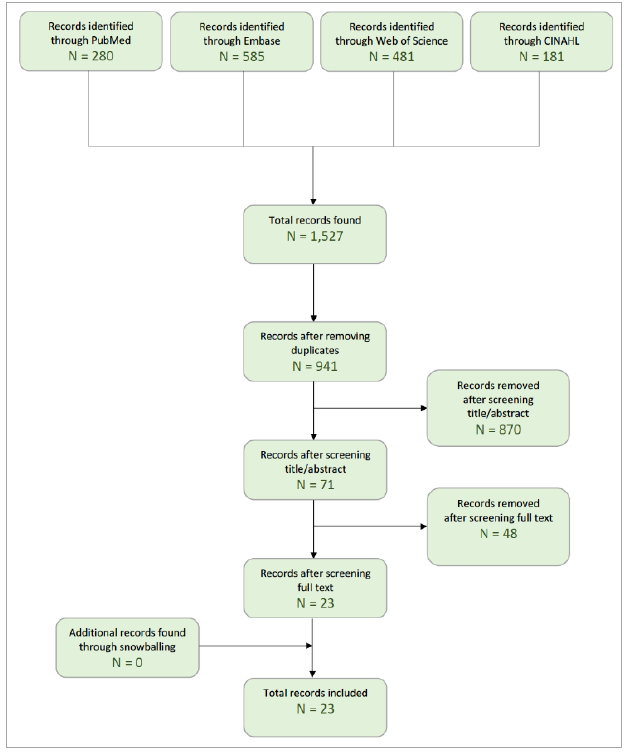
Figure 1. Flowchart of the systematic literature review process. Table 2. Patient-reported psychosocial outcomes and tools in each study .